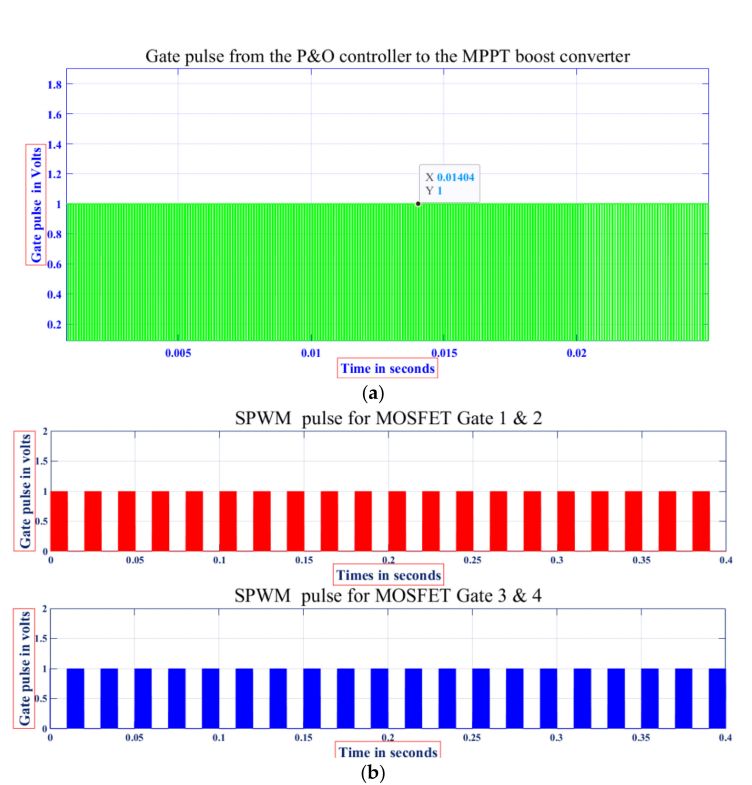
Figure 11. ( a ) Gate pulse of the P&O-based MPPT controller. ( b ) Inverter gate